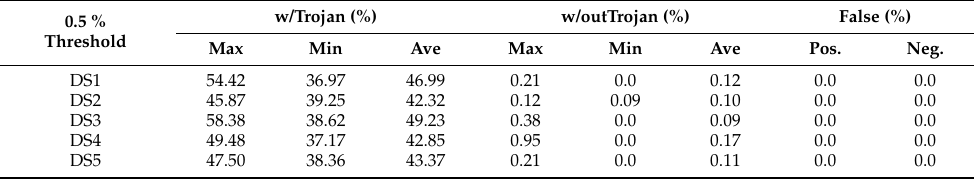
Table 3. Percentage of violations in Data Sets (DS)